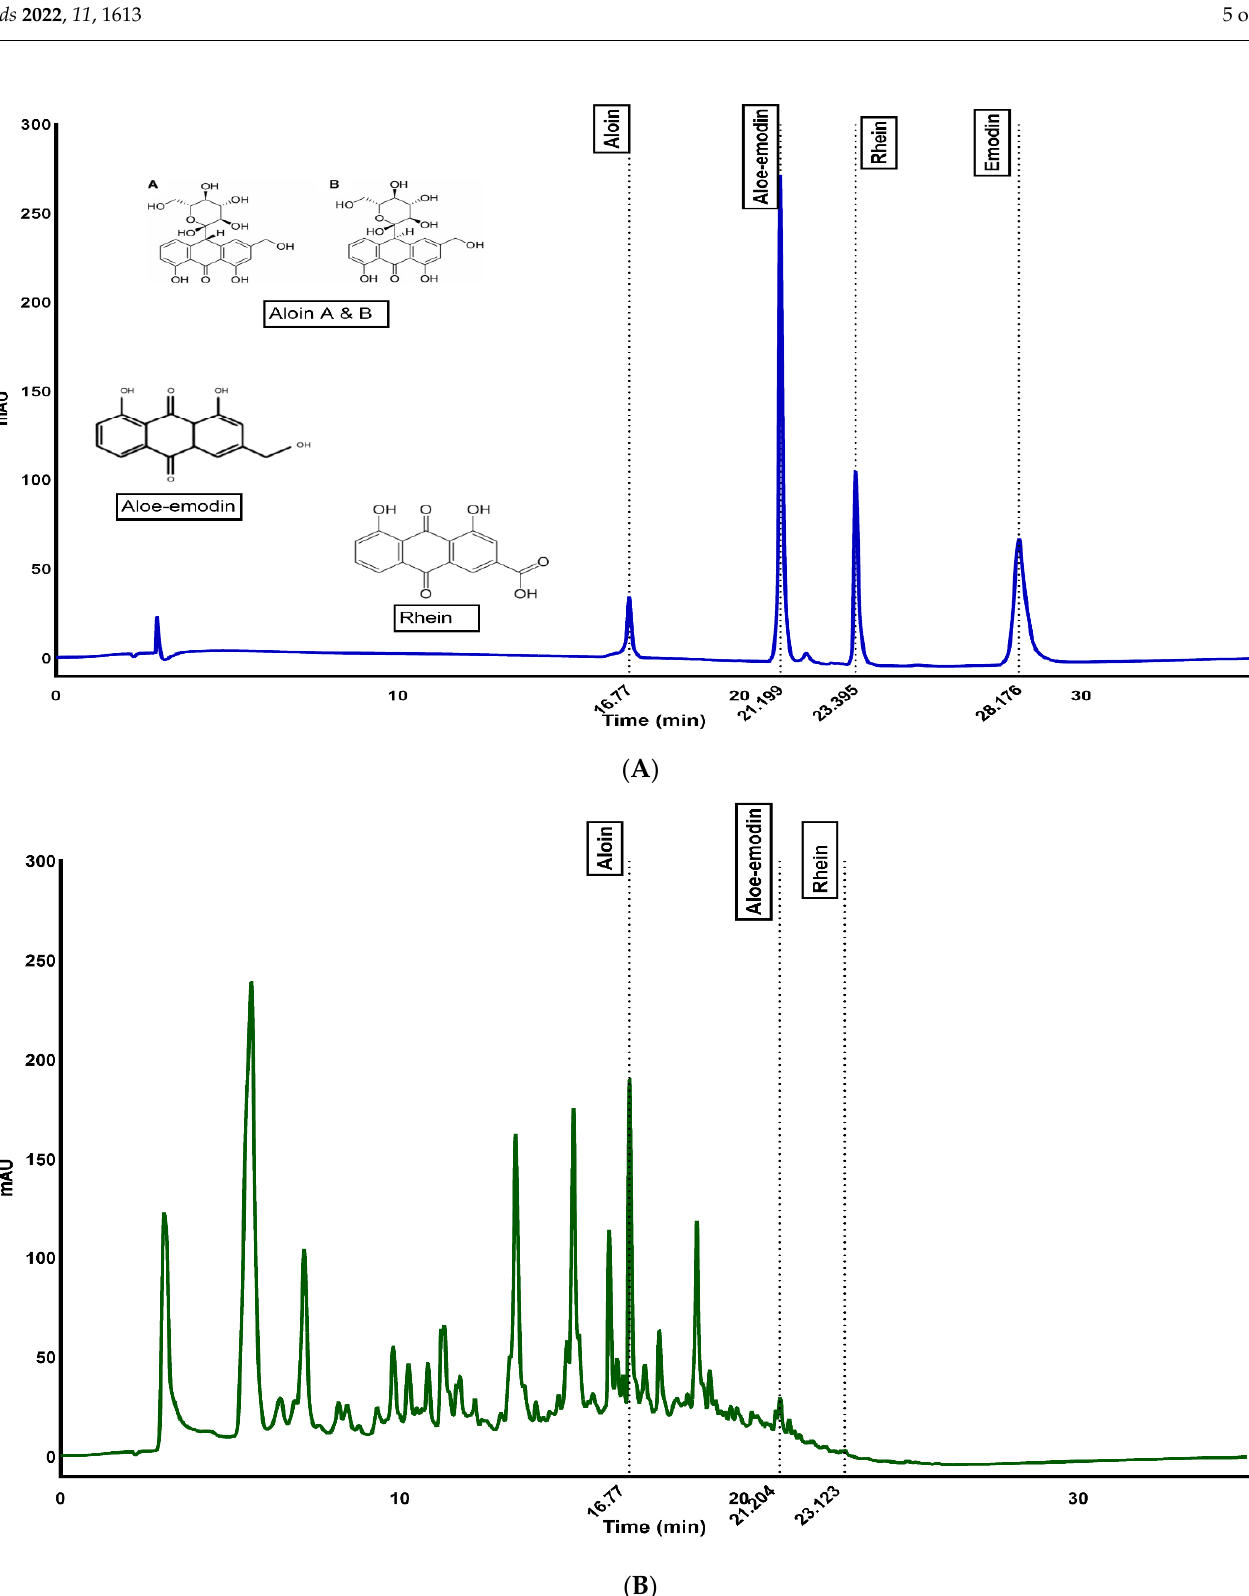
Figure 1. HPLC chromatographs of ( A ) reference standards of aloin, aloe ‐ emodin and rhein and ( B ) WLAG extract containing aloin, aloe ‐ emodin and rhein .